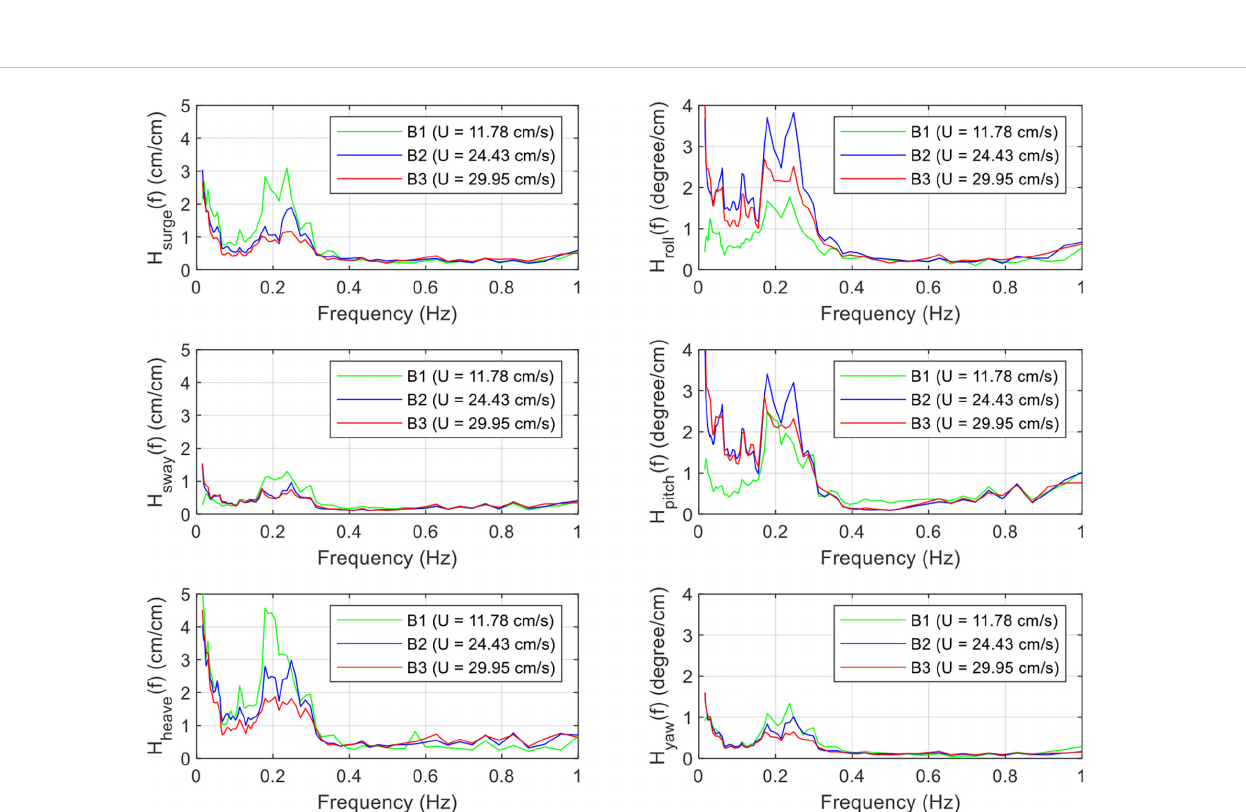
FIGURE 17 In fl uence of the current velocity on the linear transfer function of the 6 DOF motions of the fl oating collar under the mooring line failure of a net cage in irregular waves and currents (numerical